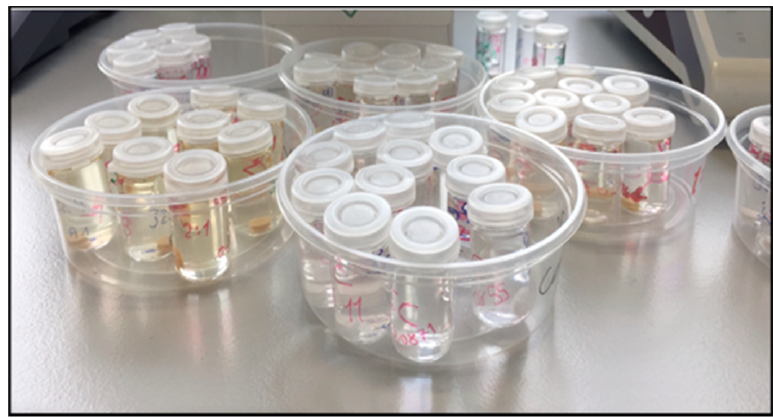
Figure 3. Specimens immersed in distilled water for 7 days.